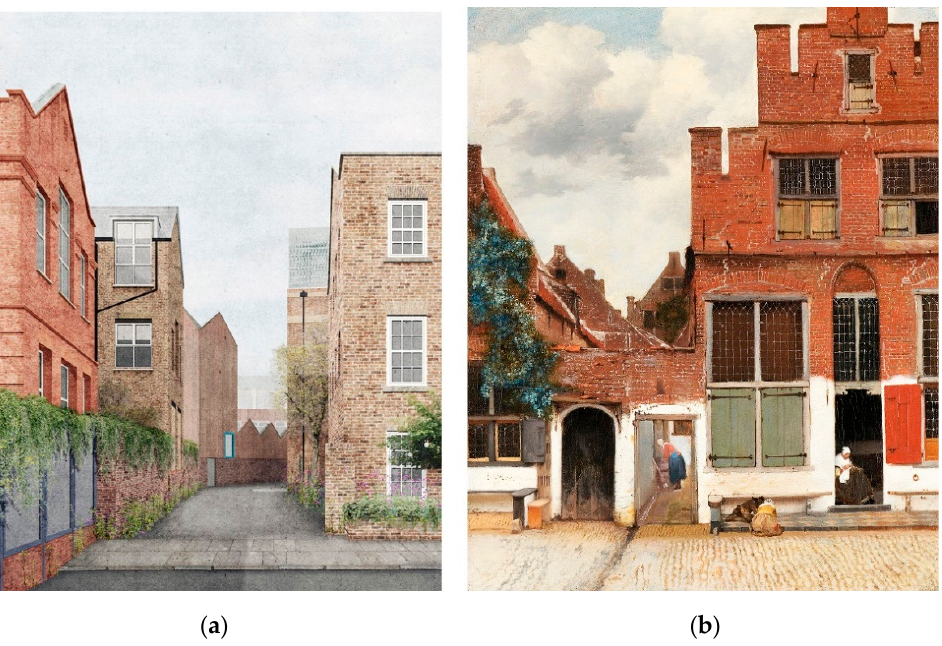
Figure 1. ( a ) Arts and Wellbeing Centre, London, Sergison Bates, c. 2018. © Sergison Bates. ( b ) The Little Street, Johannes Vermeer, 1658. Oil on canvas. Rijksmuseum, Amsterdam, NL. (Image in the public domain).